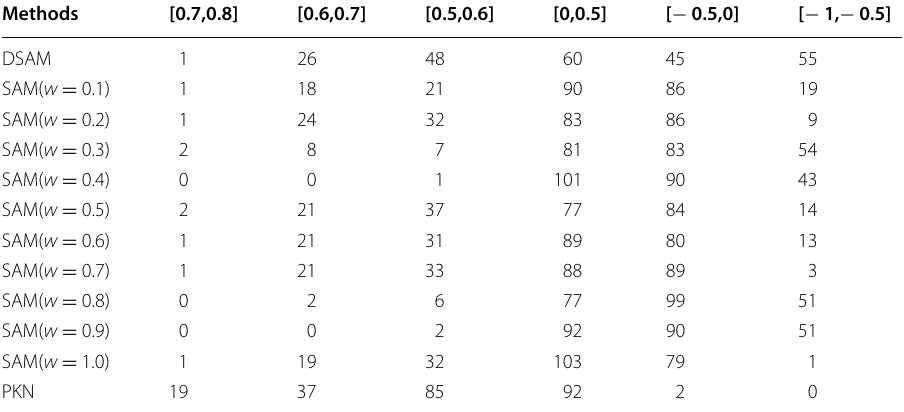
Table 3 Statistics of Spearman values calculated for 235 time slots of Orbcomm